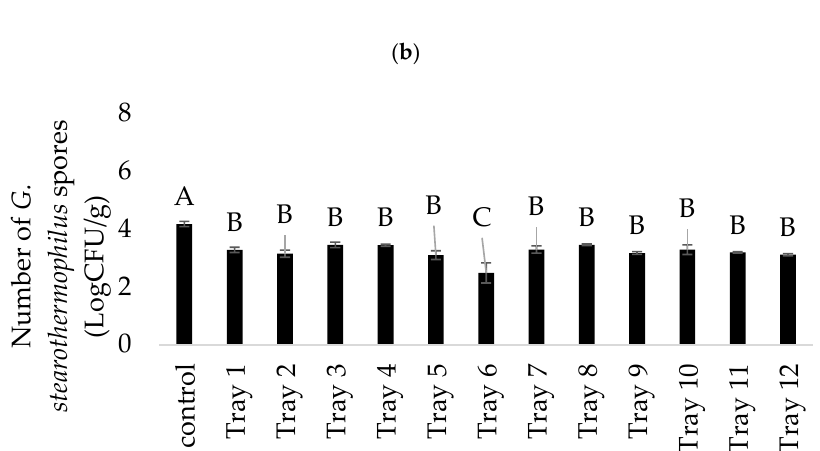
Figure 5. Inoculation map for spore pouches ( G. stearothermophilus ), where the set up represents a carrier tray with 12 packaging trays and the black squares shows the cold spot for pouch inoculation ( a ) G. stearothermophilus spores surviving post CiMPAS processing (R-121) using pouch inoculation ( b ) and whole tray inoculation ( c ) Di ff erent letters in each graph indicate a significant di ff erence ( p < 0.05); na = Not applicable for